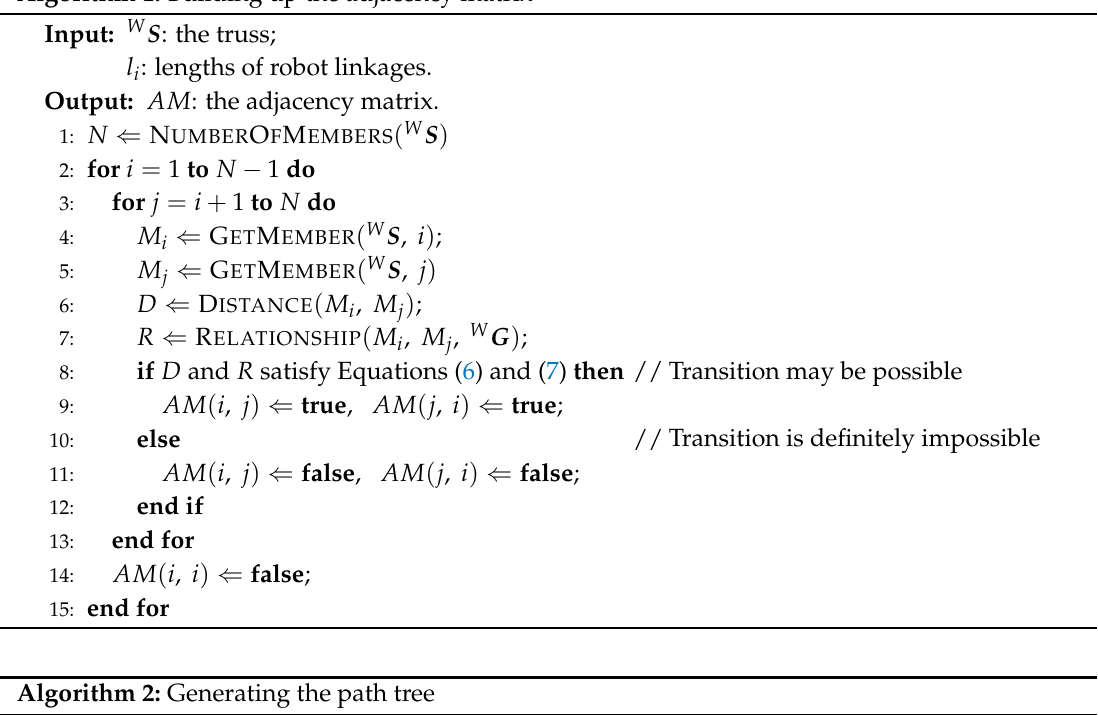
Algorithm 1: Building up the adjacency matrix